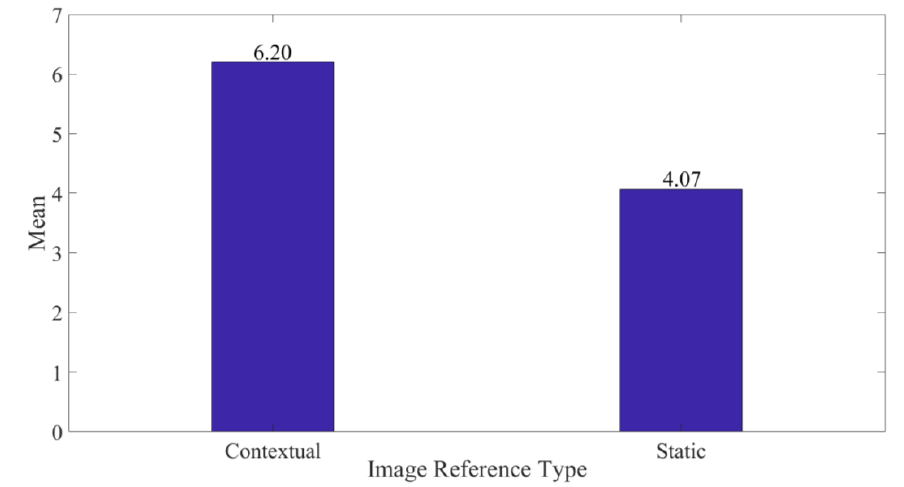
Figure 14. Average Preference against Image Reference Type.